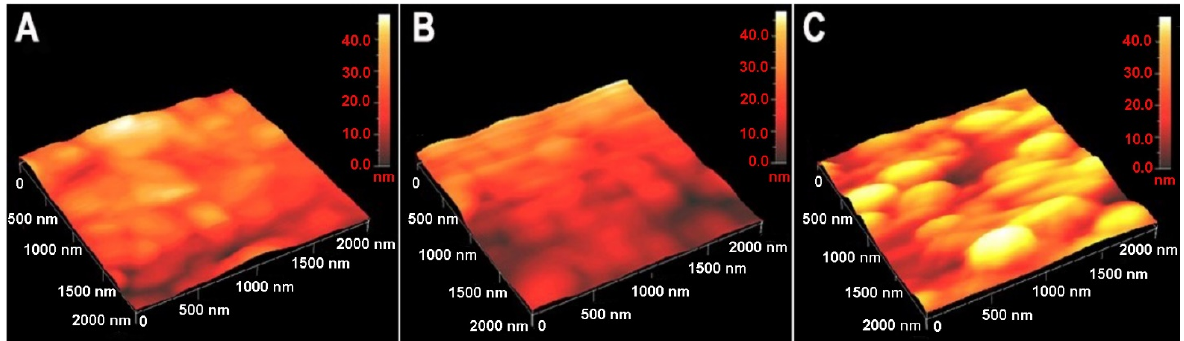
Figure 3. AFM 3D images (2 µm × 2 µm) of ( A ) the mica substrate coated with a thin film of Au (111), ( B ) the TBBT monolayer, and ( C ) the AuNP-modified Au surface.